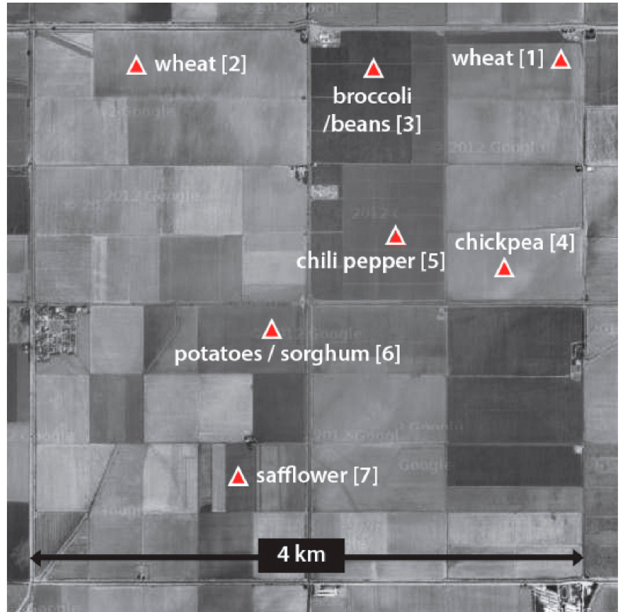
Figure 2. Satellite view of the study zone with respective positions of the eddy covariance flux towers and their associated crop type (Imagerie© 2012 Cnes/Spot Image. DigitalGlobe. Données cartographiques© 2012 Google (City, US State abbrev., Country ; Inst. Nat. Estat. y Geog, INEGI).